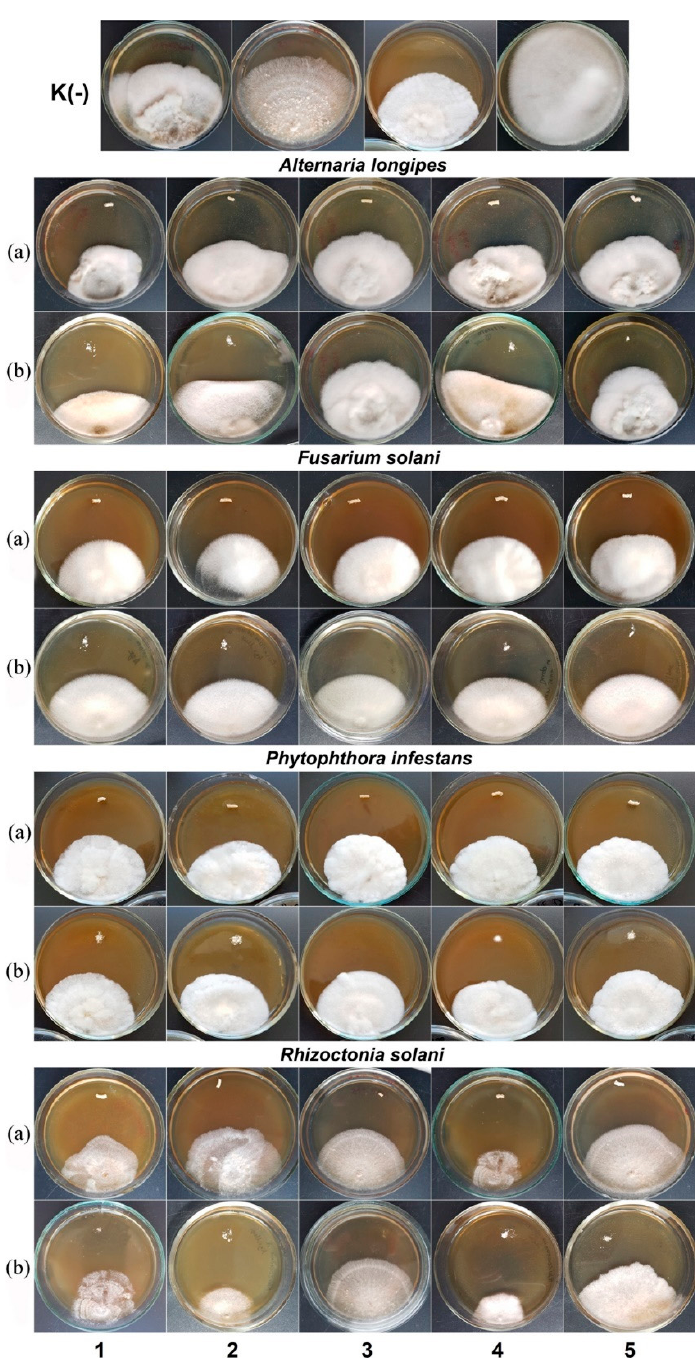
Figure 11. Growth of mycelium of phytopathogenic fungi on the fungicide-free medium (K(-)— negative control) and on the media with embedded ( a ) and free ( b ) fungicides: 1—azoxystrobin, 2— azoxystrobin + mefenoxam, 3—mefenoxam, 4—difenoconazole, 5—prothioconazole.